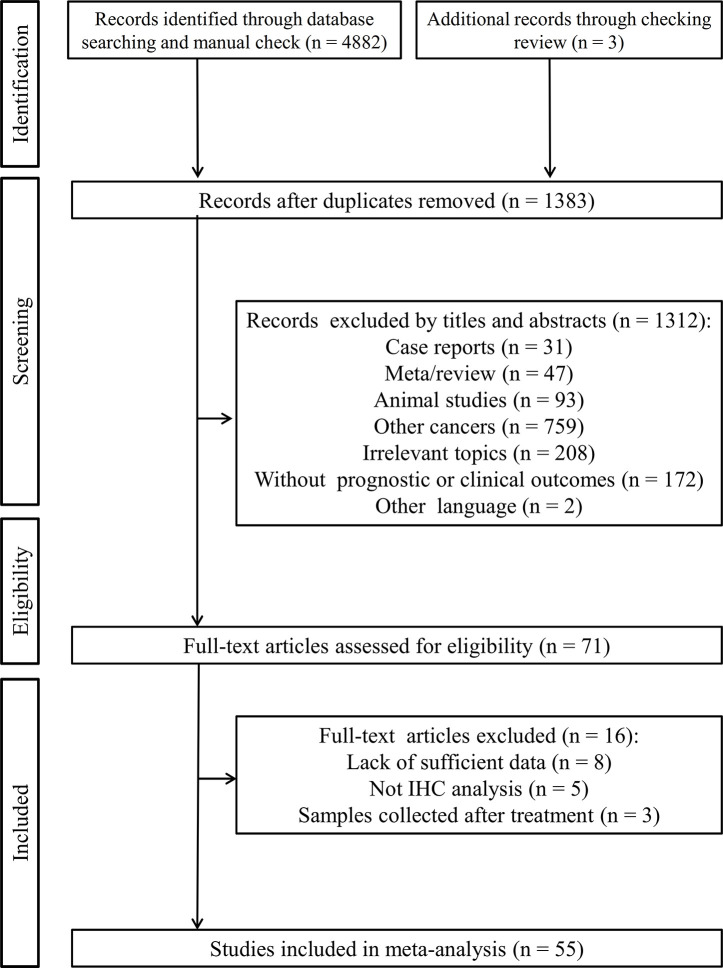
Flowchart of the study inclusion process.